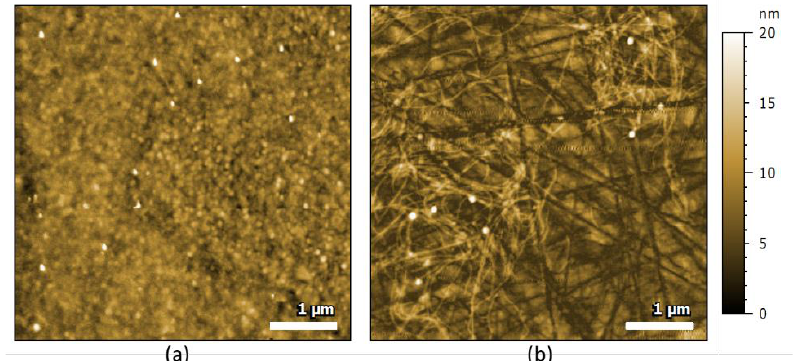
Figure 1. AFM topography of the Aβ42 samples at different incubation times; representative images of three images for each condition. ( a ) Just after the addition of a HCl 10 mM solution, the sample displays oligomers characterized by circular forms (white dotted shapes). ( b ) After one week of incubation at 37 °C in 10 mM HCl, we observe long fibrils with a diameter of around 10 nm as expected for amyloid fibrils (fibrils are the brighter filaments on the surface, while the scratches of the prism are the darker broad straight lines. Some oligomers remain visible as white dotted spots). In Figure 2, we display the AFM-IR spectra of both species, obtained with a bottom-up illumination through a prism and the ATR-FTIR spectra. The spectrum of oligomers (Figure 2a) shows two major bands. The one located around 1660 cm −1 corresponds to random or α-helical structure. The band present at 1630 cm −1 is characteristic of β-sheet structure. We also observed a shoulder at 1690 cm −1 absent of the fibrils’ spectrum. The concomitant appearance of these two bands and their relative intensities indicates the presence of an anti-parallel β-sheet structure for the oligomeric state. Amyloid fibrils (Figure 2b) have a higher β-sheet content, as indicated by the higher intensity of the IR band at 1630 cm −1 . The 1690 cm −1 shoulder band completely vanishes. On the amide II band, we can also observe that the maximum of the band shifts. On the oligomer, the amide II band shows a band at 1531 and a shoulder at 1547 cm −1 . For the fibrils, the maximum is at 1552 and a shoulder appears at 1536 cm −1 . The decrease in the 1531 cm −1 band with an increase in the 1552 cm −1 band is also a typical signature of the aggregation of protein from oligomers to fibrils [22] and confirmed the major structure for fibrils is parallel β-sheet structure. These two distinct secondary structures for oligomers and fibrils have already been observed for Aβ42 and other amyloid proteins